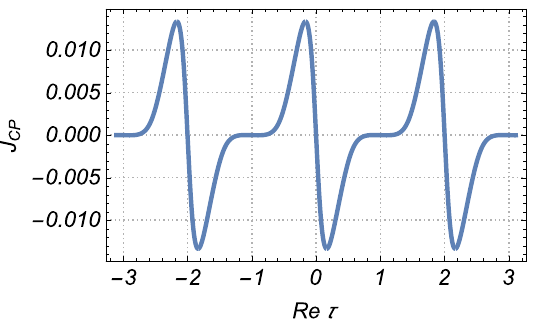
Figure 3 . The relationship between a real part of the complex structure modulus Re τ and the Jarlskog invariant J CP in Sample